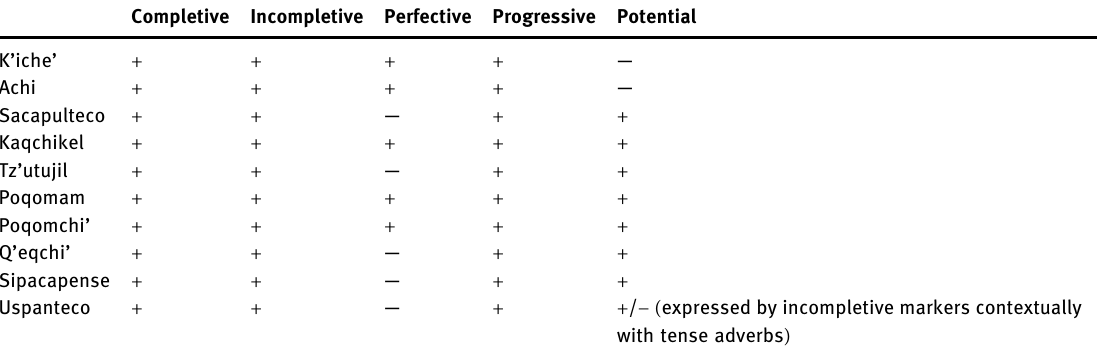
Completive Incompletive Perfective Progressive